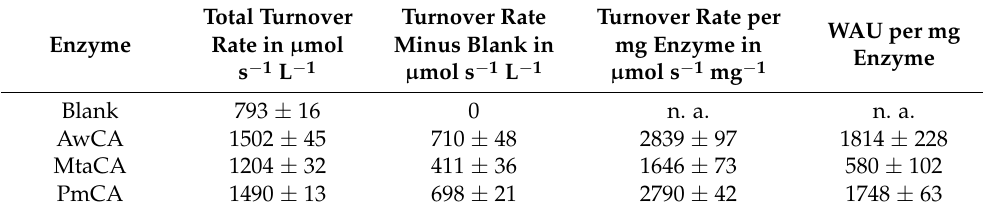
Table 1. Calculated hydratase activities at 25 ◦ C for AwCA, MtaCA and PmCA in turnover rate per mg enzyme and WAU per mg enzyme.